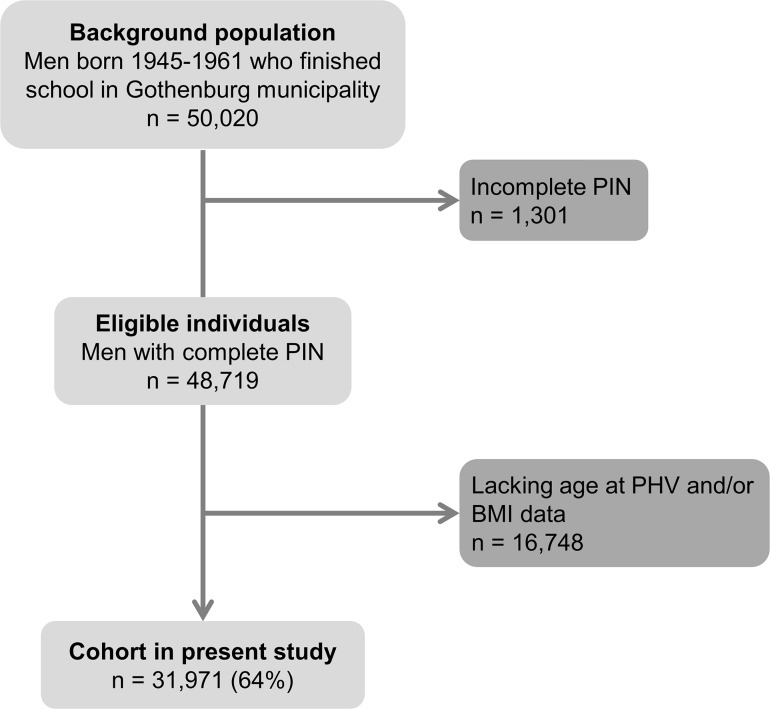
Flow chart of the BMI Epidemiology Study Gothenburg participants included in the present study.BMI, body mass index; PHV, peak height velocity; PIN, personal identity number.